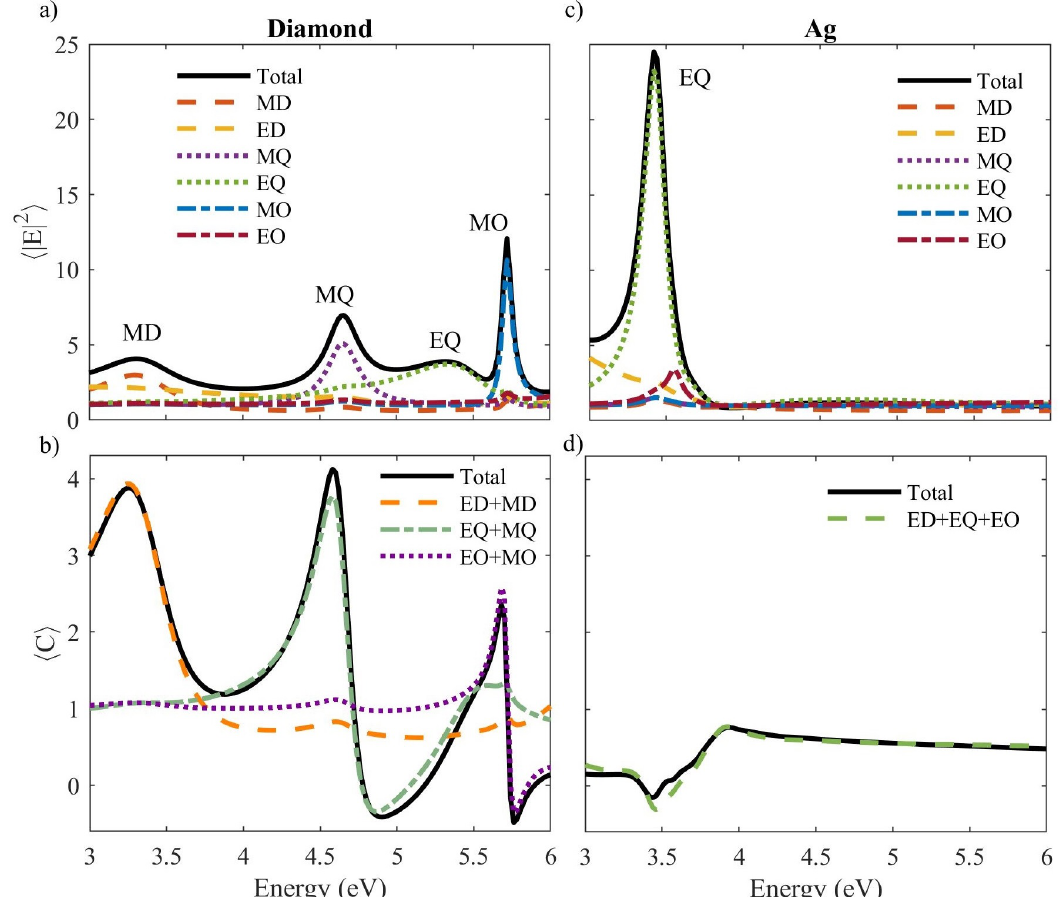
Figure 5. Surface averaged near-field enhancement (NFE) and optical chirality density (OCD) enhancement spectra (black solid lines) for diamond ( a , b ) and Ag ( c , d ). The contribution of the different multipolar terms is shown with dashed lines (ED = Electric Dipolar, MD = Magnetic Dipolar, EQ = Electric Quadrupolar, MQ = Magnetic Quadrupolar, EO = Electric Octopolar (Hexapolar), MO = Magnetic Octopolar